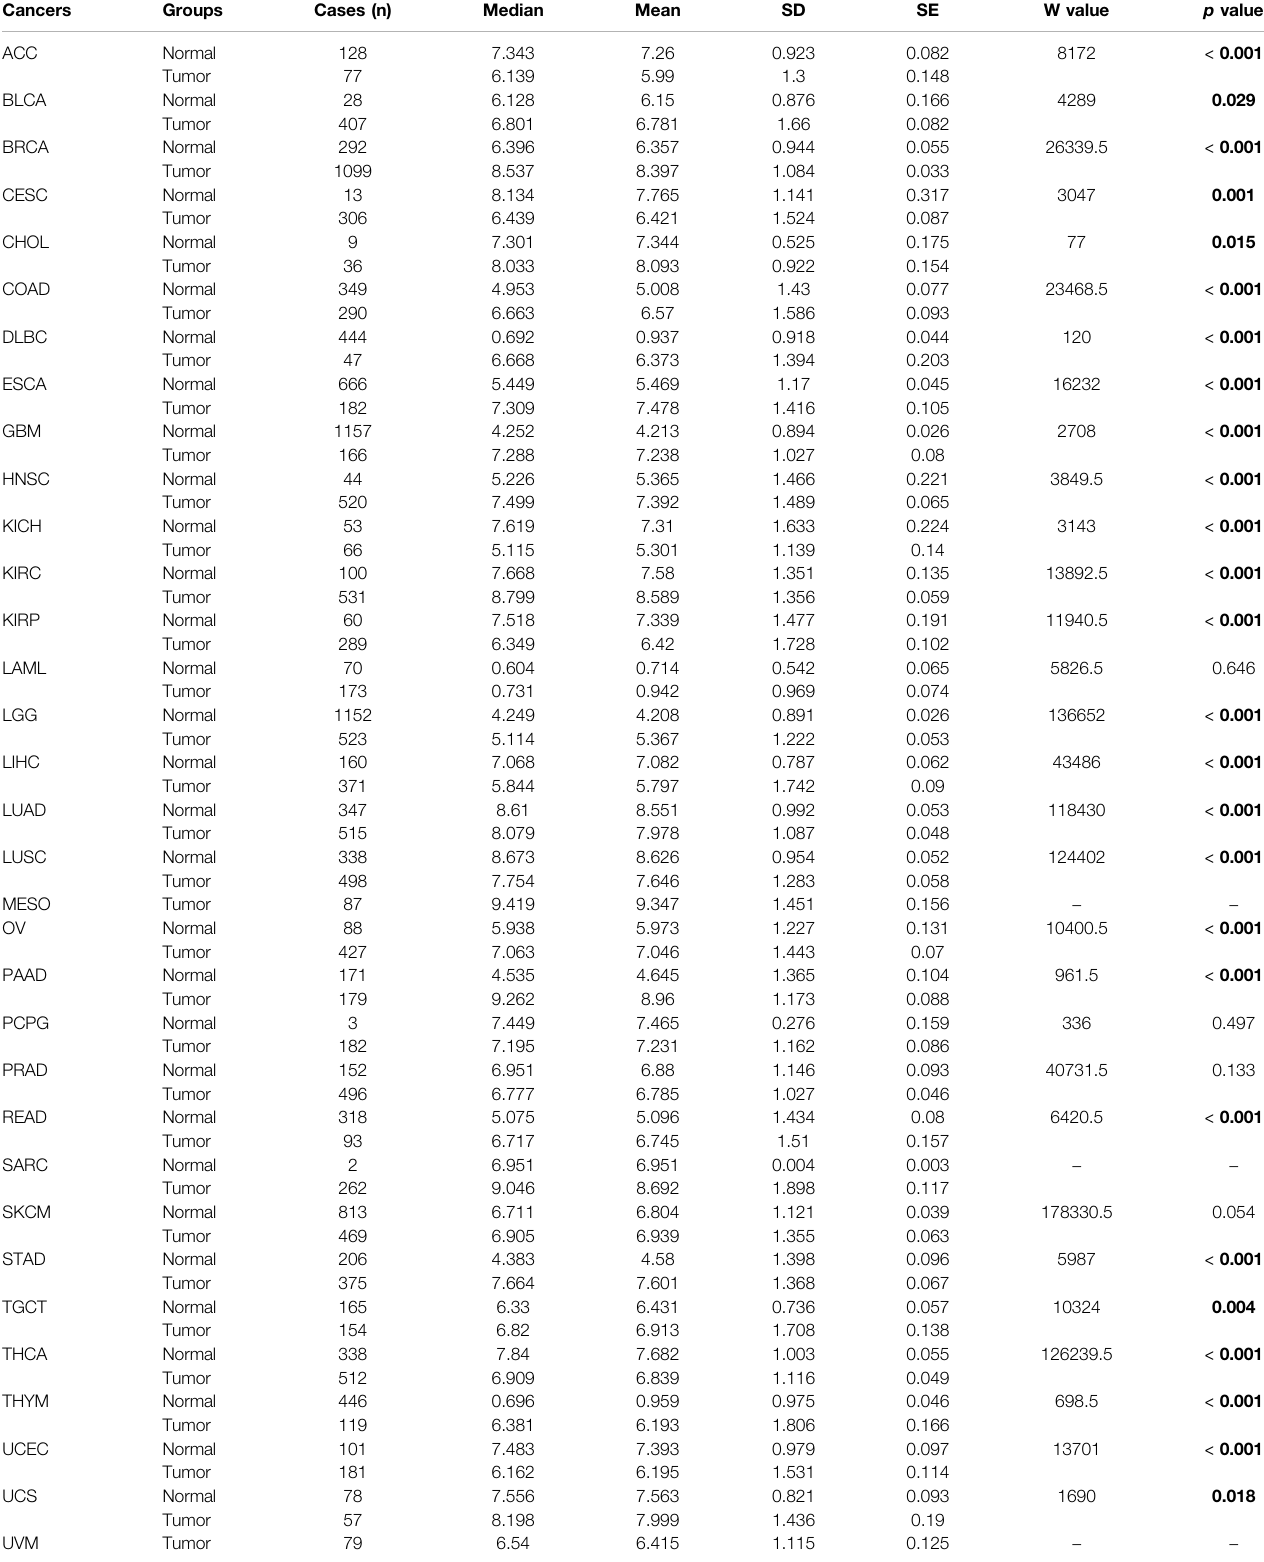
Bold indicates statistically signi fi cant, that is, a p value less than